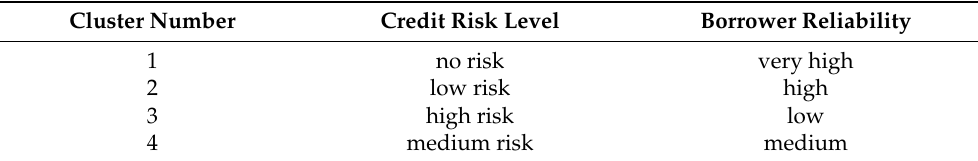
Table 7. Clusters of borrowers with corresponding characteristics of credit risk and reliability.